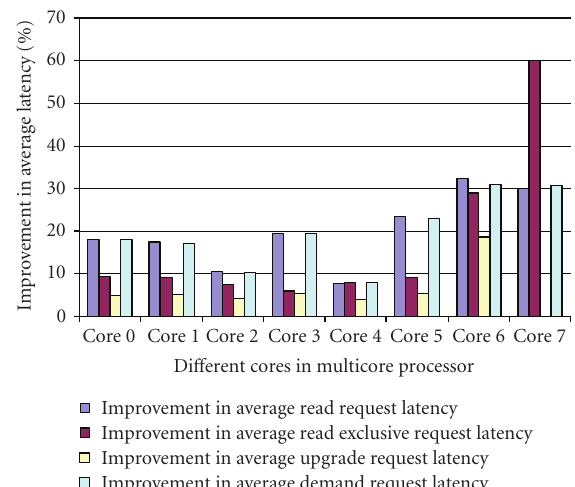
Figure 21: Improvement in average latency for di ff erent type of L2 cache requests-LU